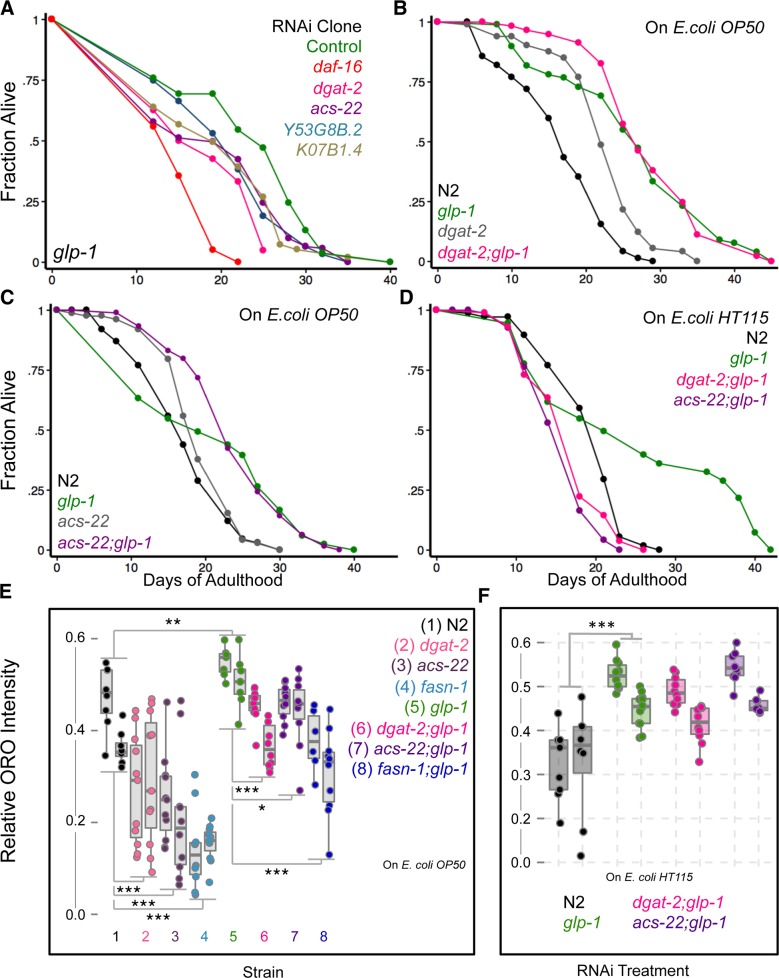
DGAT-2 and ACS-22 exhibit redundant and diet-dependent effects on the longevity and lipid content of germline-less mutants.A. RNAi inactivation ‘dgat’ genes shortens glp-1 mutants longevity modestly. glp-1 mutants were subjected to RNAi during adulthood by feeding bacteria containing empty control vector (green) or bacteria expressing dsRNA targeting ‘dgat’ genes. Control (green; m = 23.2 ± 0.3, n = 63/83), daf-16 (red; m = 15.2 ± 0.3, n = 79/79; P vs. control <0.0001), dgat-2 (pink; m = 18.5 ± 0.7, n = 71/80; P vs. control <0.0001), acs-22 (purple, m = 19.7 ± 1.3, n = 123/123, P vs. control, 0.006), Y53G8B.2 (blue, m = 20.7 ± 0.5, n = 59/71, P vs. control 0.02) and K07B1.4 (sand, m = 19.9 ± 1.0, n = 97/97, P vs. control, <0.0001). B, C. Effect of dgat-2(hj44) and acs-22(hj26) mutations on the lifespan of glp-1 mutants and wild-type (N2) worms on E. coli OP50. B.
glp-1 (green; m = 26.5 ± 0.5, n = 76/85), dgat-2;glp-1 (pink; m = 28.5 ± 1.0, n = 52/61; P vs. glp-1 0.64), N2 (black; m = 16.7 ± 0.7, n = 76/91, P vs. glp-1 <0.0001), dgat-2 (gray; m = 22.6 ± 0.6, n = 75/88; P vs. N2 <0.0001). C:
glp-1 (green; m = 21.0 ± 0.9, n = 92/96), acs-22;glp-1 (purple; m = 23.6 ± 0.6, n = 97/103; P vs. glp-1 0.87), N2 (black; m = 17.0 ± 0.7, n = 69/100), acs-22 (gray; m = 19.1 ± 0.5, n = 72/83; P vs. N2 0.1). Additional trials are shown in S6B and S6C and S7(A) Tables. D. Effect of dgat-2(hj44) and acs-22(hj26) mutations on the lifespan of glp-1 mutants grown during adulthood on E. coli HT115 with the empty control vector. N2 (black; m = 19.16 ± 0.5, n = 57/75), glp-1 (green; m = 24.2 ± 1.6, n = 43/60), dgat-2;glp-1 (pink; m = 16.3 ± 0.4, n = 87/98; P vs. glp-1 <0.0001), acs-22;glp-1 (purple; m = 15.7 ± 0.4, n = 75/86). E, F. Effect of dgat-2(hj44), acs-22(hj26) and fasn-1(fr8) mutations on fat levels of glp-1 mutants. Quantification of lipid levels compared between different strains through ORO staining on day 2 adults grown on E. coli OP50 (E) or E. coli HT115 (F). The mutations caused reduced ORO staining in both fertile and glp-1 backgrounds when grown on E. coli OP50. On E. coli HT115, dgat-2;glp-1 and acs-22;glp-1 did not show a significant ORO diminution. The box plots illustrate data from two biological replicates tested for each strain. Asterisks represent the P values {<0.05 (*), <0.005 (**) or <0.0001 (***)} derived using the multcomp package. See S6 Fig for ORO data of day 4 and 8 adults, and Methods for details of the statistical analyses.